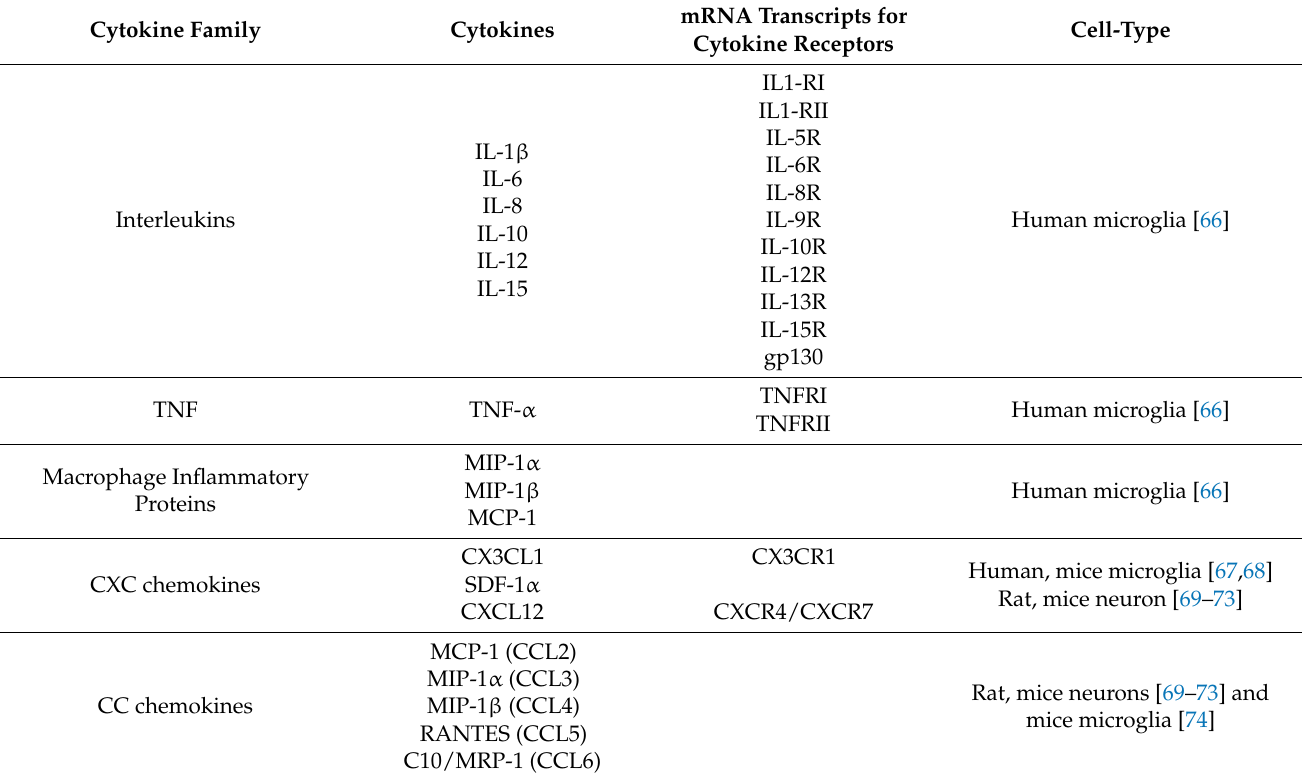
Figure 1. Neuronal gp130 signalling via IL-6R activates STAT3, which causes miR-21-5p upregulation, inhibition of PTEN, and decreased Caspase-3 and -9, thus reducing the likelihood of apoptosis; miR- Table 1. Cytokines and mRNA transcripts for cytokine receptors identified in unstimulated human, rat and mice microglia and